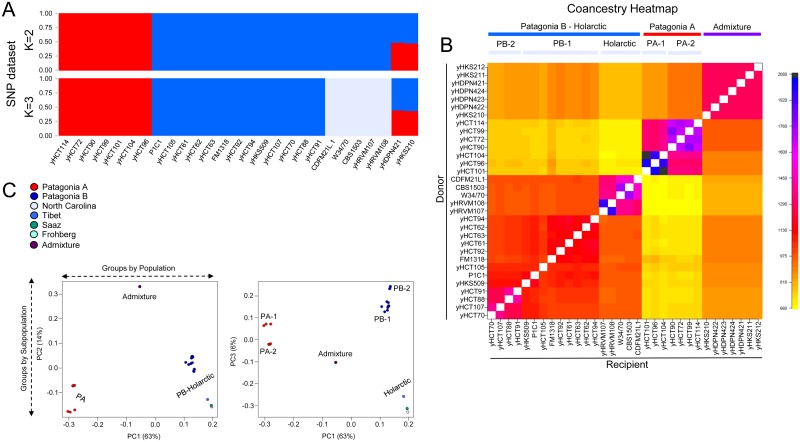
Population structure of S. eubayanus.A) Inference of the genetic clusters (K) and composition of individuals utilizing the WGS data in STRUCTURE. The most consistent number of genetic clusters/populations was K = 2 with a ΔK2 value = 805.70 (K = 3 was not a significant improvement, Evanno’s report ΔK3 = 174.78). K = 2 and K = 3 summary plots from five independent runs are shown. Each color in the bar plots represents the cluster membership coefficients. The presence of several colors in the same strain suggests admixture. B) Coancestry heatmap where darker colors indicate higher coancestry between strains. Hypothesized donor strains are on the y-axis, while hypothesized recipients are on the x-axis. Colored bars indicate populations, and grey bars indicate subpopulations. C) Principal Component Analysis (PCA) plots. PC1 versus PC2 accounted for 77% of the variation in the SNP dataset. PC1 was able to group strains by population. PC2 and PC3 highlight the complexity of the population structure by grouping the strains by subpopulation.